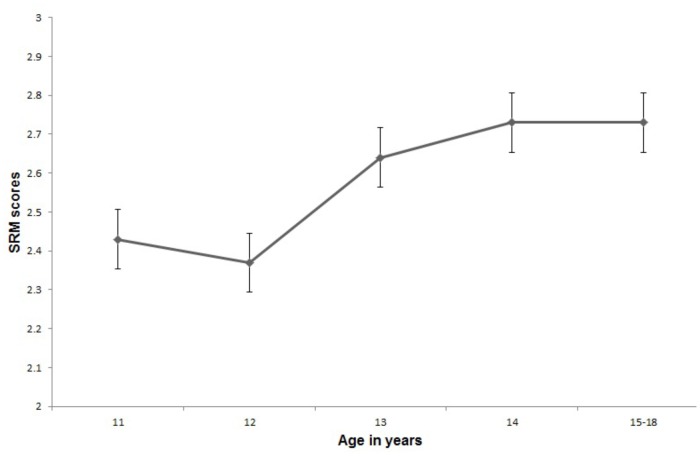
SRM scores of participant by chronological age. A line graph plotting the SRM scores of moral development and age of adolescents, 11–18 years old. Adolescents aged 15–18 were grouped together due to low numbers in the sample.